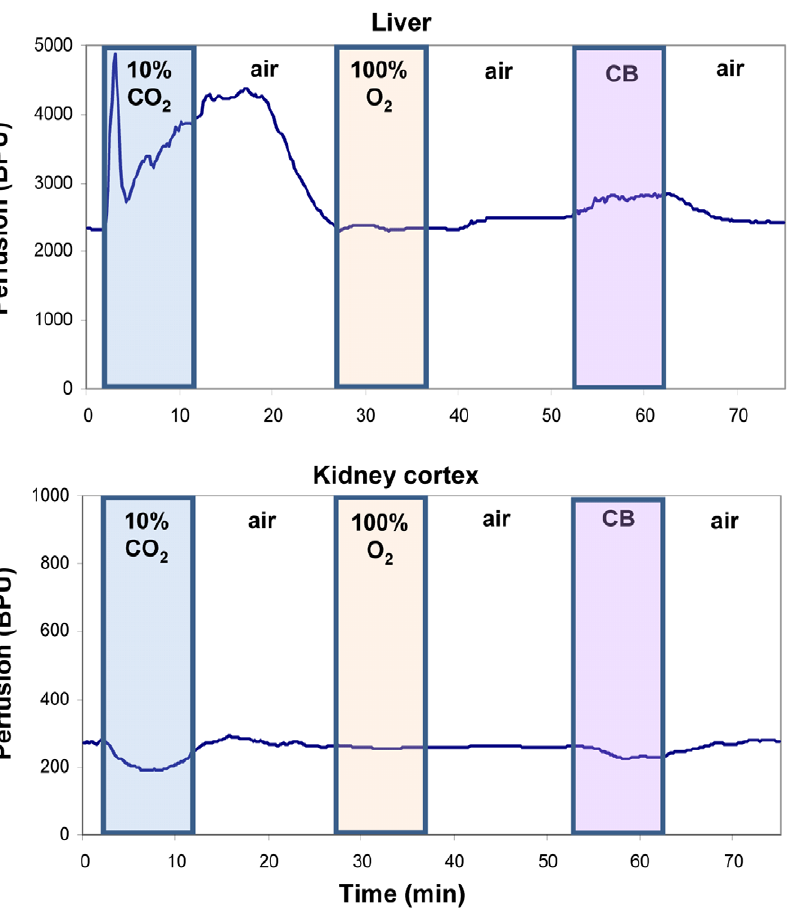
Figure 2. Real-time tissue perfusion response in the liver and kidney cortex. Results are shown for gas sequence 1. CB refers to carbogen. Units are in relative blood perfusion units (BPU).